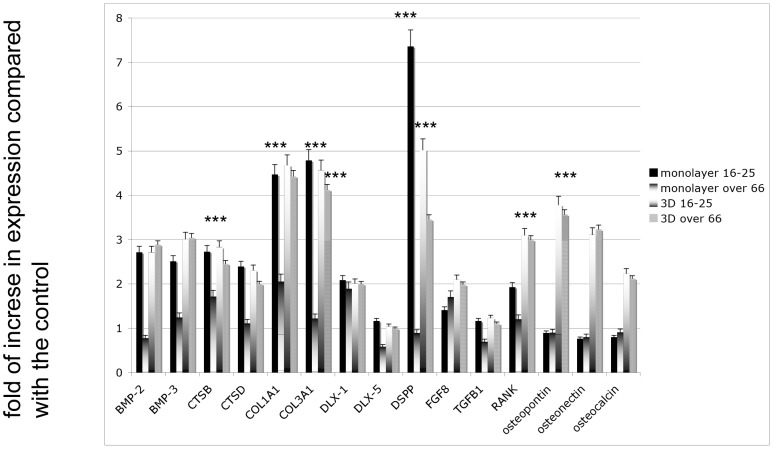
Gene expression by real-time PCR on DPSCs derived from the younger donor group (16–25) and from the senior group (over 66) in monolayers and in nanostructured scaffolds.Markers selected were bone morphogenic protein (BMP) 2, BMP-3, cathepsin B (CTSB), CTSD, collagen type I (Col1A1), collagen type III (Col3A1), Distal-less homeobox (DLX) 1, DLX5, fibroblast growth factor (FGF), transforming growth factor β1 (TGFβ1), receptor activator of nuclear factor kappa-B (RANK), osteopontin, osteonectin, and osteocalcin. The results for each experiment are from quadruplicate experiments. Values are expressed as the mean ± SD. T tests were used to determine significant differences (p<0.05). * p<0,05; * * p<0,01; * * * p<0,001.